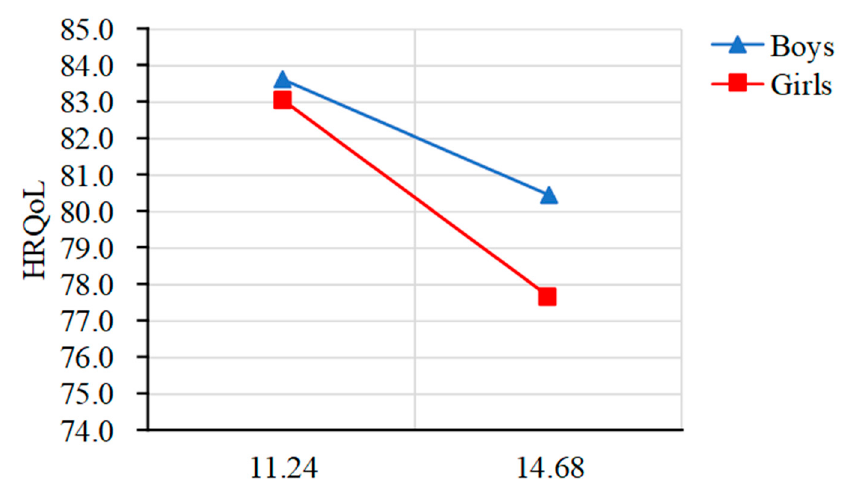
Figure 5. Gender moderated the relationship between age and health-related quality of life. Note: Higher score of interpersonal trust represents interpersonal mistrust.